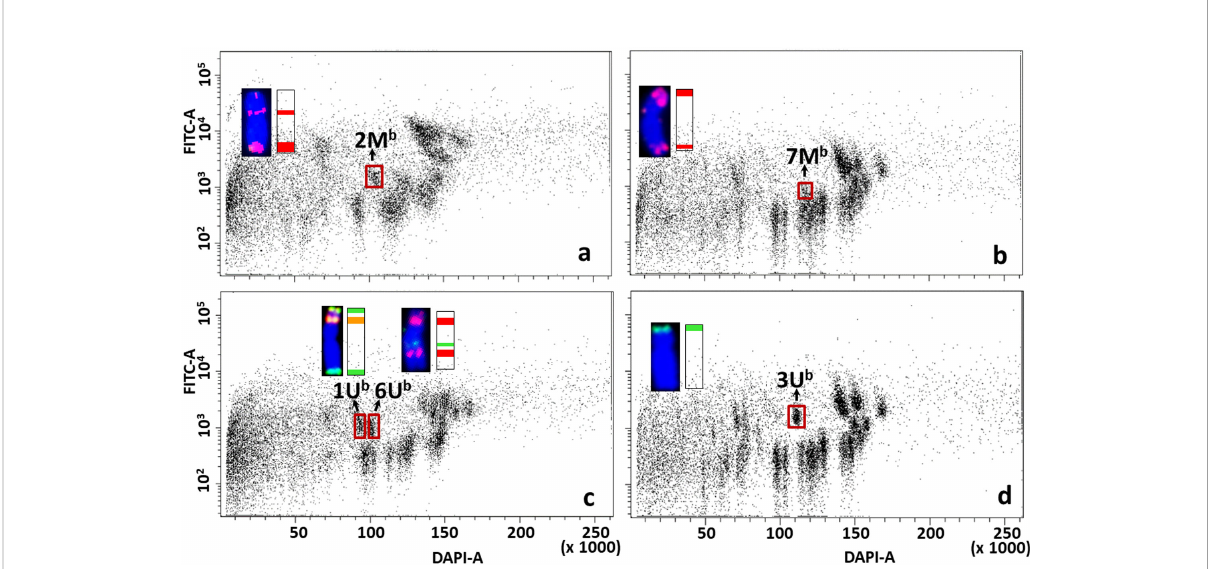
FIGURE 7 Bivariate fl ow karyotypes DAPI vs. FITC obtained after FISHIS with (GAA) 7 on chromosomes isolated from wheat Mv9kr1- Ae. biuncialis acc. MvGB642 addition lines. The analysis permitted discrimination of chromosomes from tetraploid Ae. biuncialis (brown boxes) in the genetic background of bread wheat (A – D) . The chromosomes (inset) were sorted in high purity and identi fi ed by FISH on microscope slides with probes for Afa family repeat (red), 45S rDNA (orange) and pSc119 .2 repeat (green). Chromosomes were counterstained with DAPI (blue). x-axis, relative DAPI fl uorescence; y-axis, relative (GAA) 7 -FITC fl